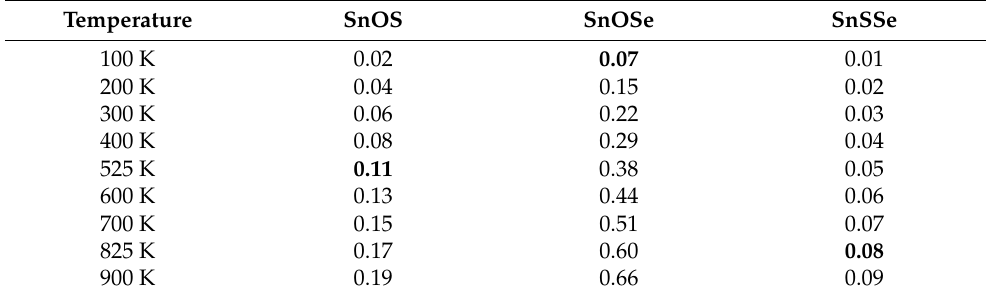
Table 2. The summary of δ values for the three Janus monolayers SnXY at different temperatures, where the critical values at Tmax are shown in bold.